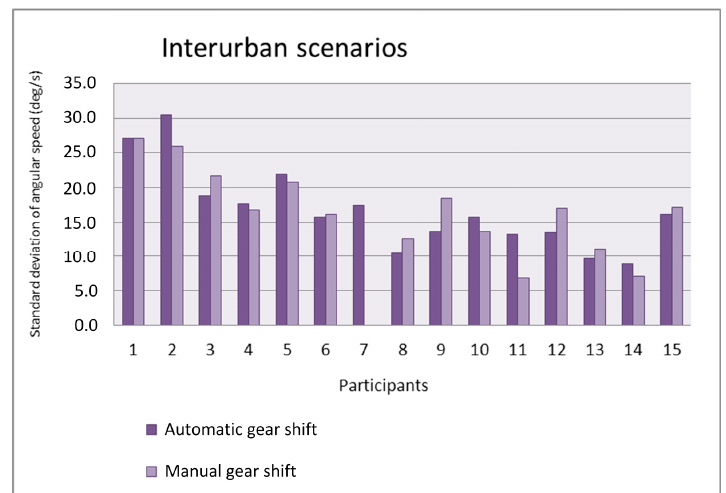
Figure 14. Standard deviation of the angular speed as a function of the gear shift type in the urban scenarios.